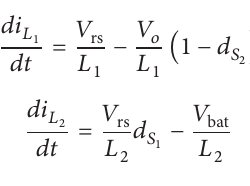
(2) During 𝑡 1 . 𝑆 1 remains off and 𝑆 3 is still on, but 𝑆 2 is turned off; the equivalent subcircuit is shown in Figure 9(c). Stored energy at inductors 𝐿 1 and 𝐿 2 is delivered to the output